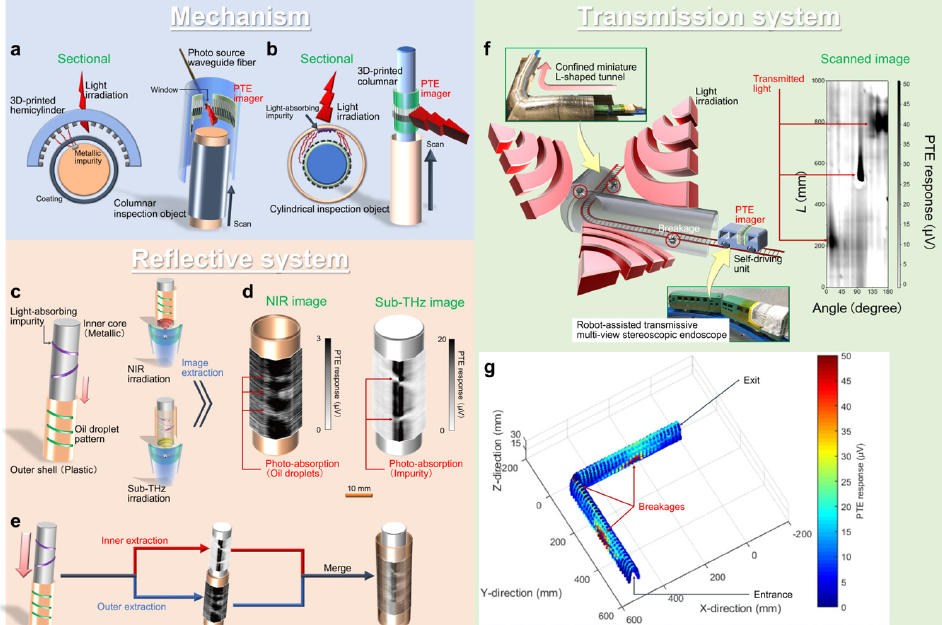
Figure 6. Demonstrations of active-style non-destructive inspections with the CNT-film-based PTE sensor sheet. ( a ) Operating mechanism of the monitoring modules in reflective and ( b ) transmission systems. ( c ) Simple diagram for the multi-wavelength reflective multi-view stereoscopic capsule PTE imaging. ( d ) Extracted reflective multi-view PTE images in NIR and sub-THz bands. ( e ) Simple reconstruction of the 3D multi-layered structure. ( f ) Simple diagram for the robot-assisted self-driving transmission multi-view stereoscopic PTE endoscopy. ( g ) 3D PTE image reconstruction of a defective L-shaped and confined miniature tunnel model. ( a – g ): Reproduced with permission from [25] Copyright 2021, the authors, published by Springer Nature.